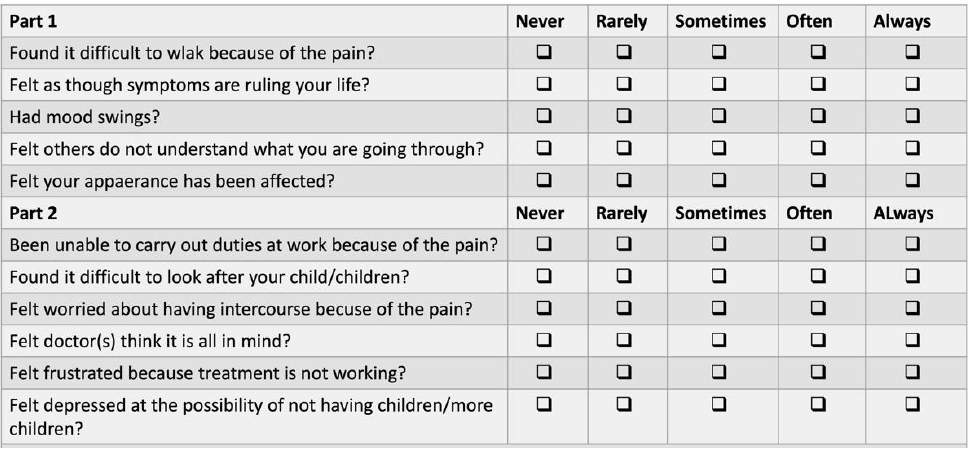
Figure 1. EHP-5 questionnaire